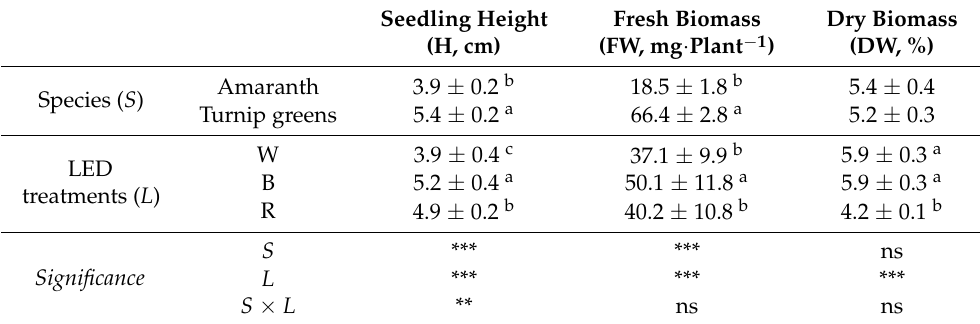
Table 1. Main effects of species (amaranth and turnip greens) and LED treatment (W = white, B = blue, R = red) on plant height, fresh biomass, and dry biomass percentage of microgreens. Seedling Height Fresh Biomass (H, cm) (FW, mg · Plant − 1 )